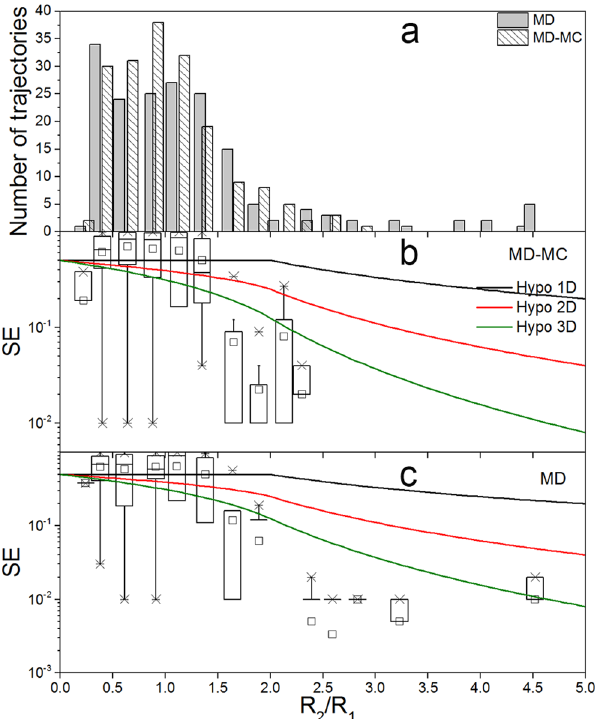
Fig 6. The distribution of trajectories and their SE against R 2 /R 1 . Trajectories from the backward MD-MC simulations and the parallel MD simulations (a); the SE for the MD-MC simulations (b) and the parallel MD simulations (c). The lines present the hypothetical SE curves in 1-D, 2-D and 3-D. The boxplots represent the distribution of the actual SE in each